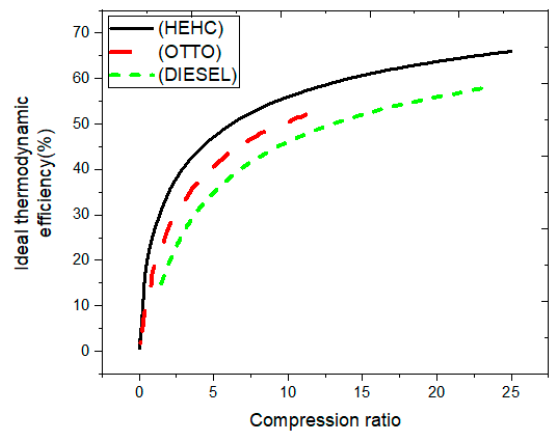
Figure 3. Ideal thermodynamic efficiency of high-efficiency hybrid cycle engine (HEHC), Otto, and diesel cycles